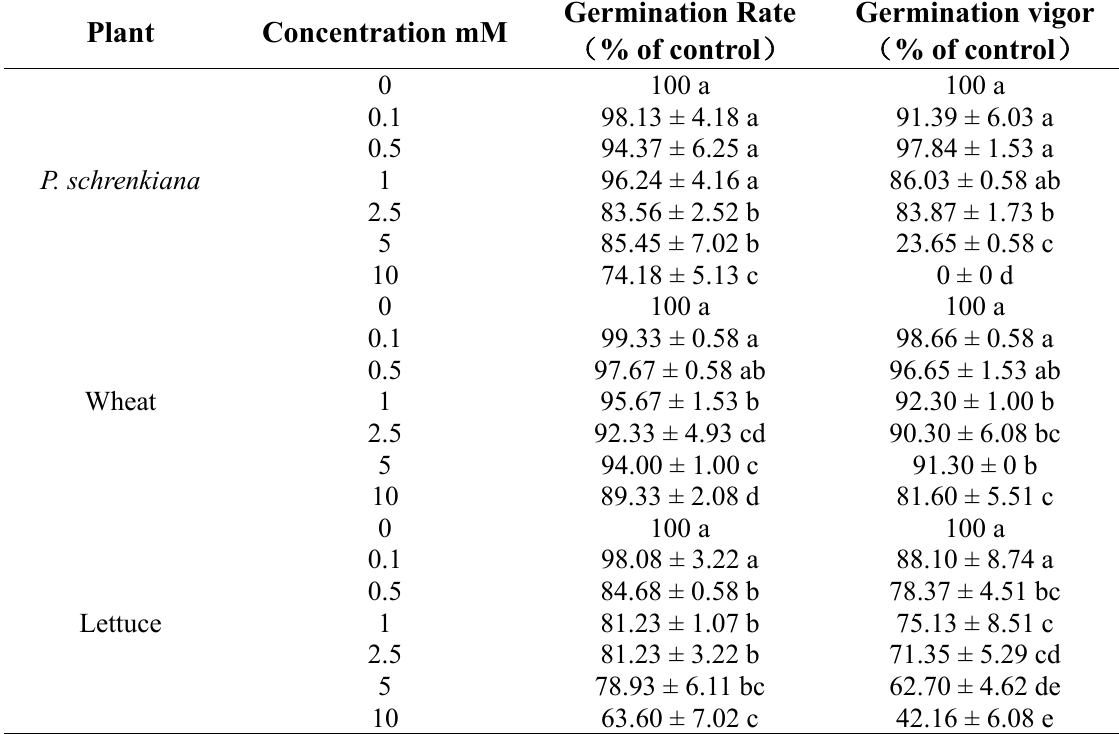
Table 1. Effects of DHAP on seed